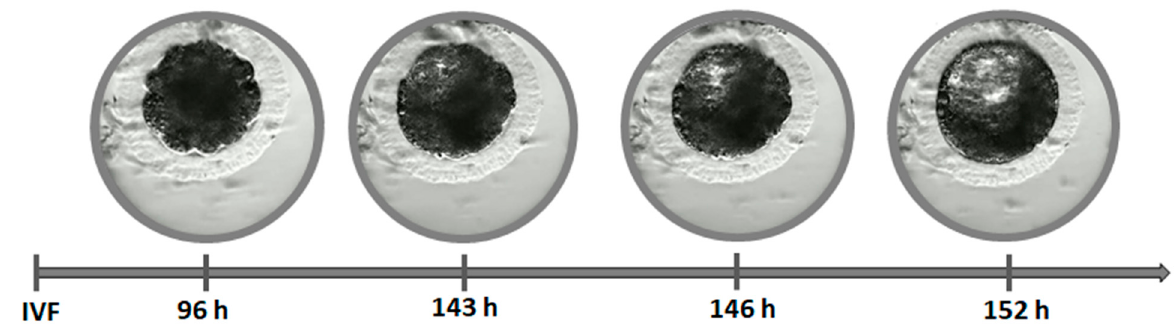
Figure 4. Timing of cavitation and blastocyst formation.